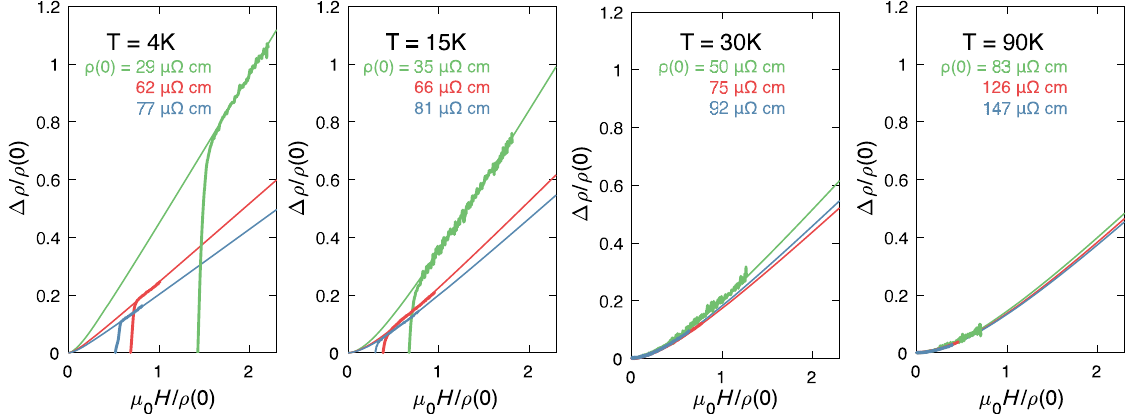
FIG. 8. Isothermal Kohler ’ s rule in quantum critical BaFe 2 ð As 1 − x P x Þ 2 ( x ¼ 0 . 31 ). A comparison of the isothermal magnetoresistance of separate samples with varying doses of alpha-particle irradiation. The violation of Kohler ’ s rule in the linear MR regime suggests that disorder scattering alters the degree of scattering anisotropy, in agreement with the hot-spot model. Solid lines are fits to Eq. (6), for which the zero-field resistivity is extracted from each trace. The curves are labeled by the resistivity of the sample at zero field at the given temperature. Note that μ 0 H= ρ ð 0 Þ is in units of Tesla = μ Ω